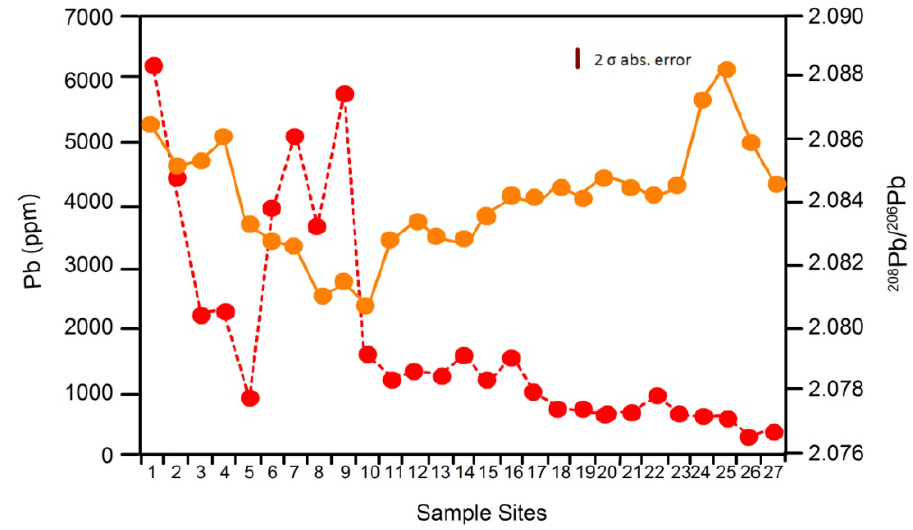
Figure 8. Downstream changes in total Pb concentration (red circles) and 208 Pb/ 206 Pb ratios (orange circles) along the River Wear, Northern England. Sample sites 1 through 27 are shown on ordinal axial and cover a distance of 86.5 km. Error bar refers to isotopic measurements (from Shepherd et al.